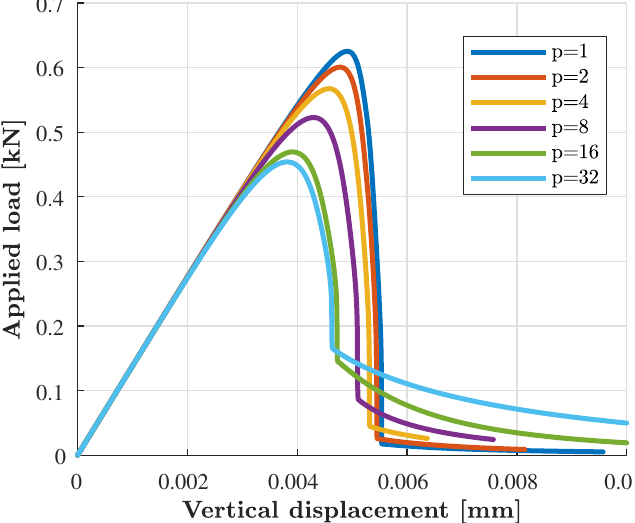
Figure 16. Tension test with cohesive phase field formulation studying effect of shape parameter p on the peak fracture